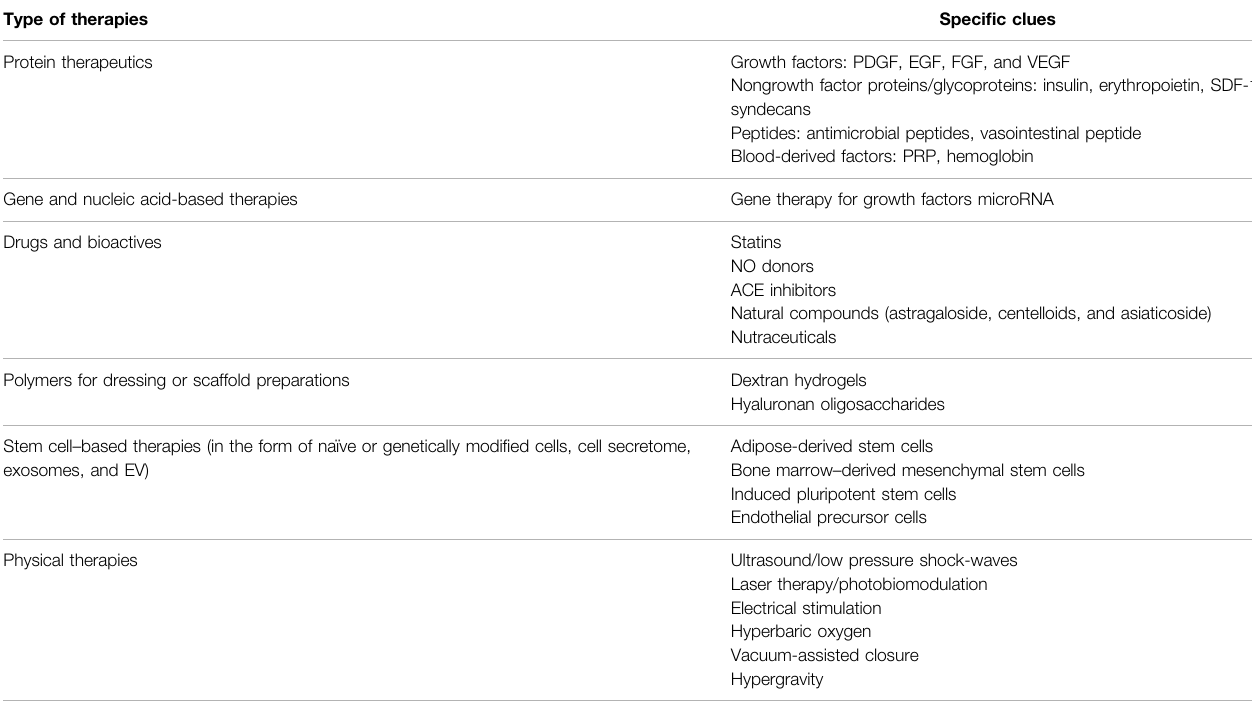
TABLE 1 | Countermeasures to improve or accelerate wound healing through enhanced angiogenesis. Type of therapies Protein therapeutics